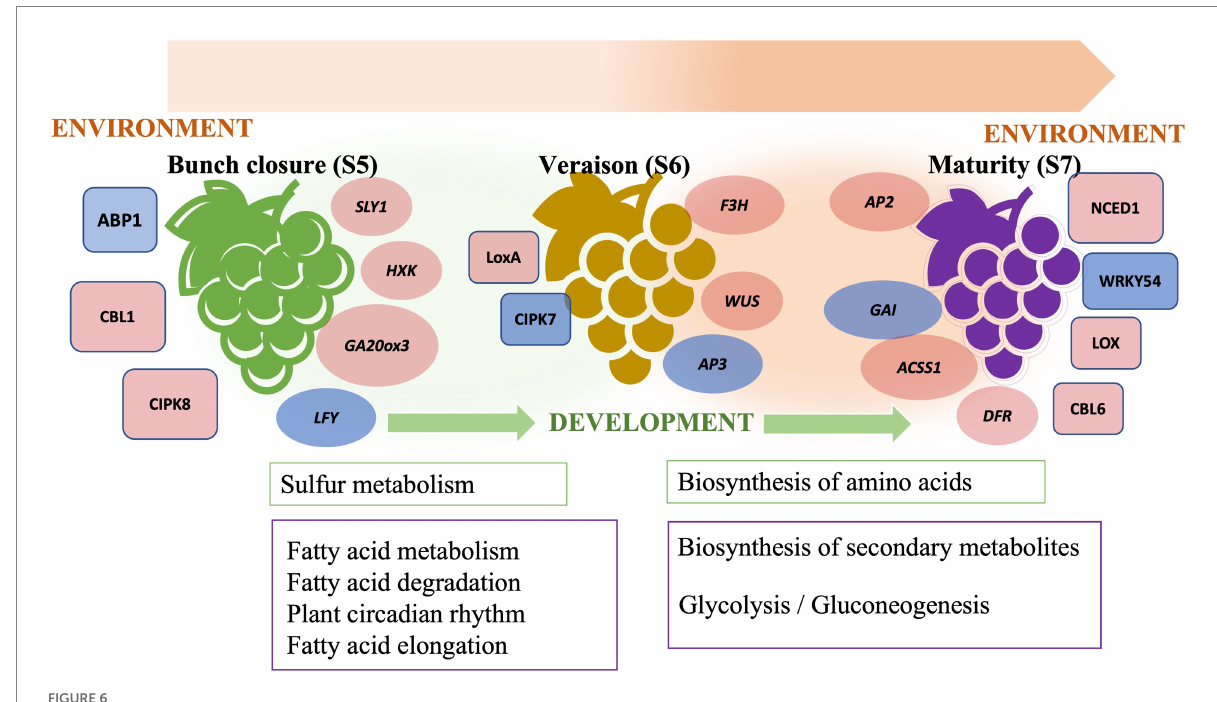
FIGURE 6 The schematic graph of berry ripening in muscadine grape.